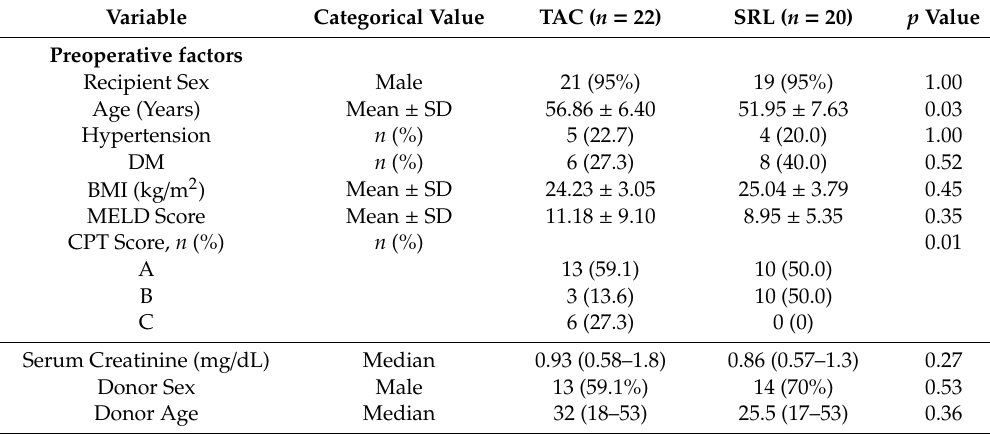
Table 1. Clinicopathologic findings in the TAC and SRL groups.